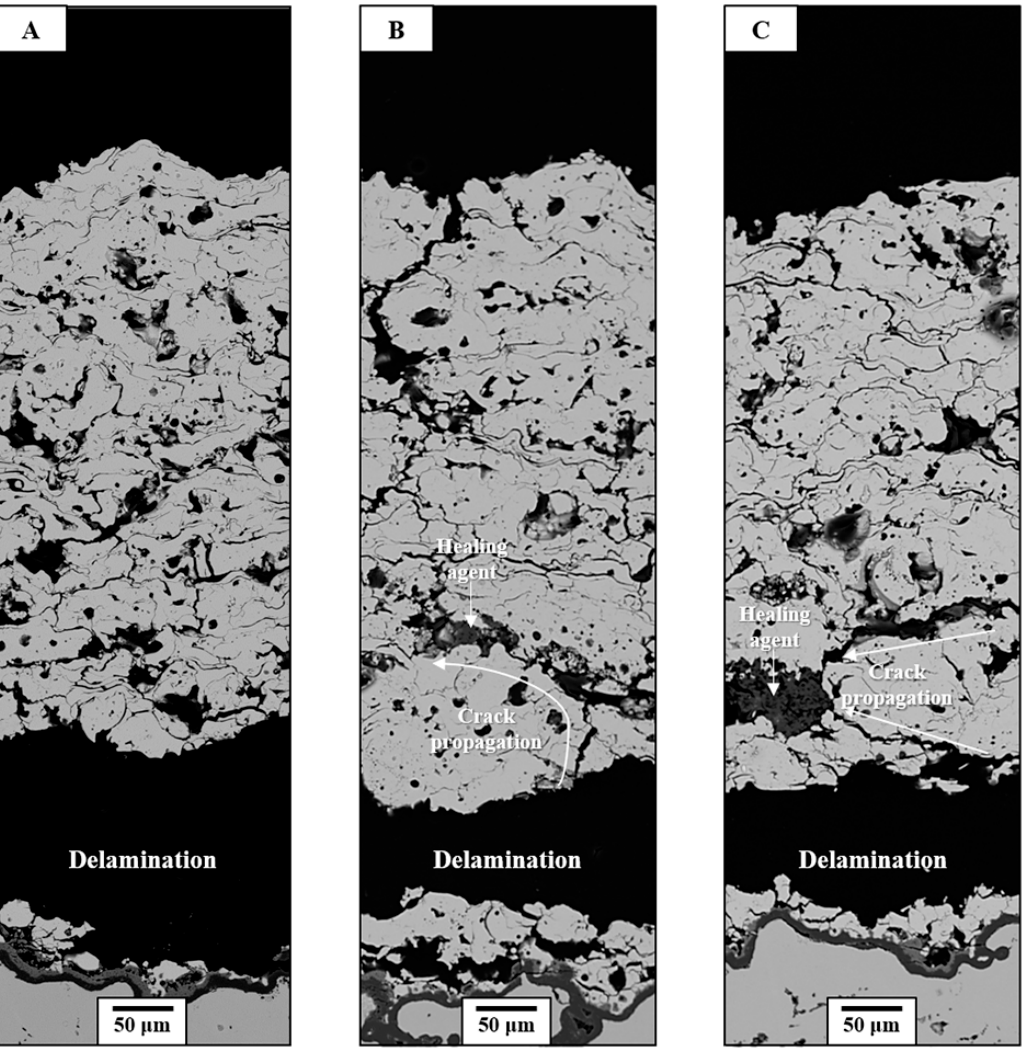
Figure 8. Cross ‐ sectional microstructures after CTF tests: ( A ) sample A, ( B ) sample B, and ( C ) sample C.